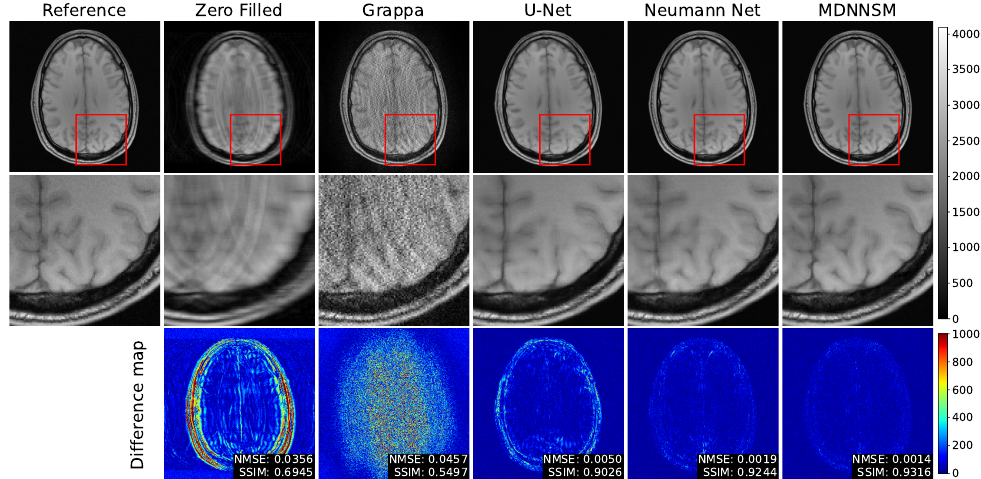
Figure 6. The top row shows fully sampled and reconstructed T1-weighted images using the zero- filled, Grappa, U-net, Neumann network, and MDNNSM methods, with an acceleration factor of 4 and an ACS rate 8%. The middle row shows detailed images zooming the red box area of the top row. The bottom row shows the difference between the reference and reconstruction images. The MDNNSM showed the lowest NMSE and the highest SSIM.